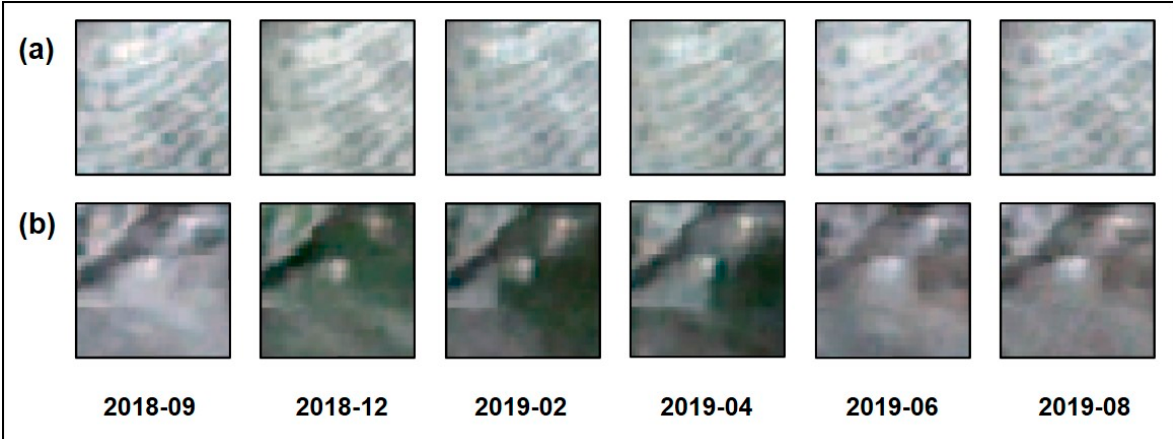
Figure 6. Temporal change of olives and non-olives on Planet imagery. ( a ) Olives have stable features over time; ( b ) some non-olives show intra-annual phenological change.